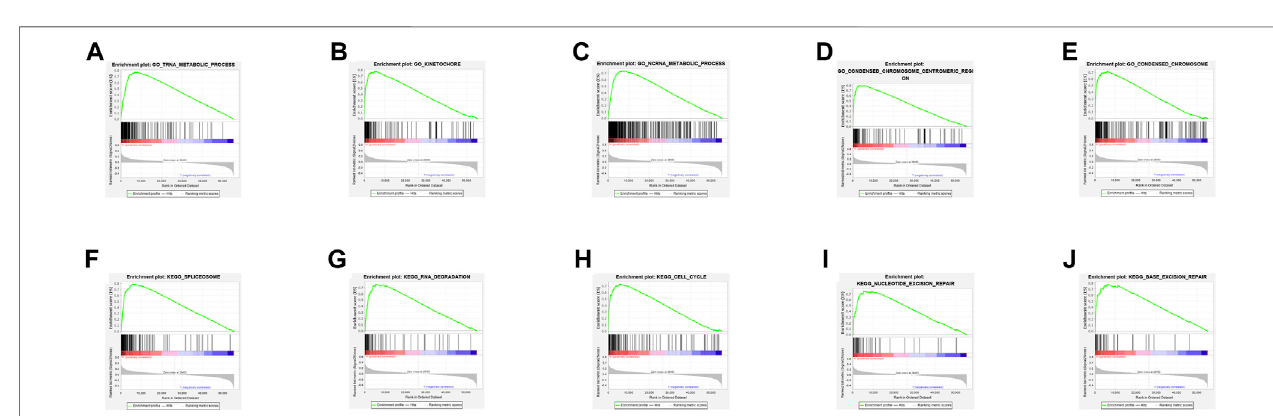
FIGURE 4 | Results of GSEA enrichment. (A – E) GO enrichment results. (F – J) KEGG enrichment results.